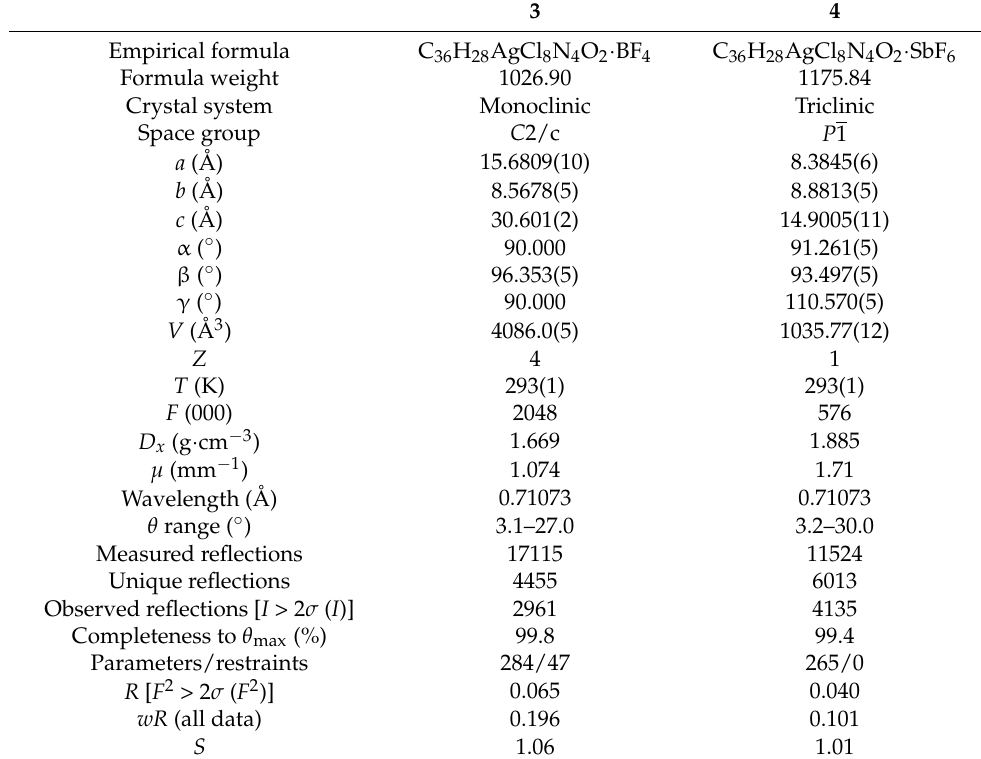
Table 5. Crystallographic data for 3 and 4